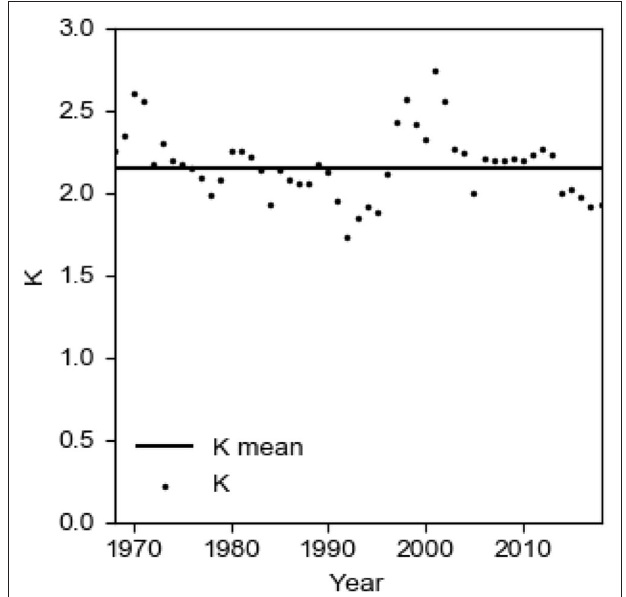
FIGURE 6 | The evolution of K = (1 + α ) in the period